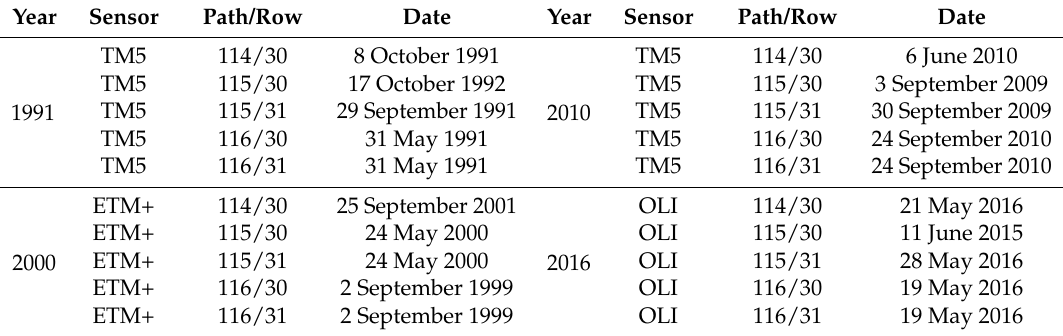
Table 1. Details of the satellite data used